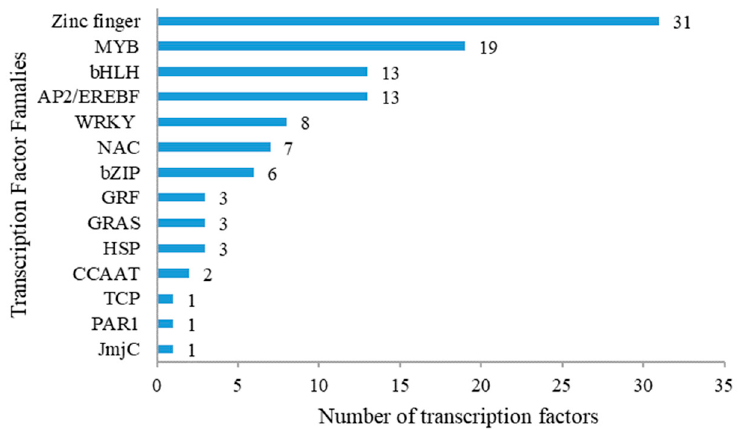
Figure 4. Transcription factors differentially expressed under drought stress in P3-198.